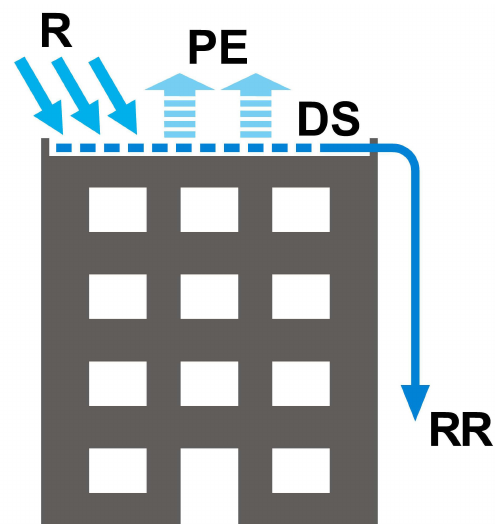
Fig. 2. Conceptual sketch of the rooftop harvesting model; R : rain- fall, PE: potential evaporation, DS: depression storage, RR: roof